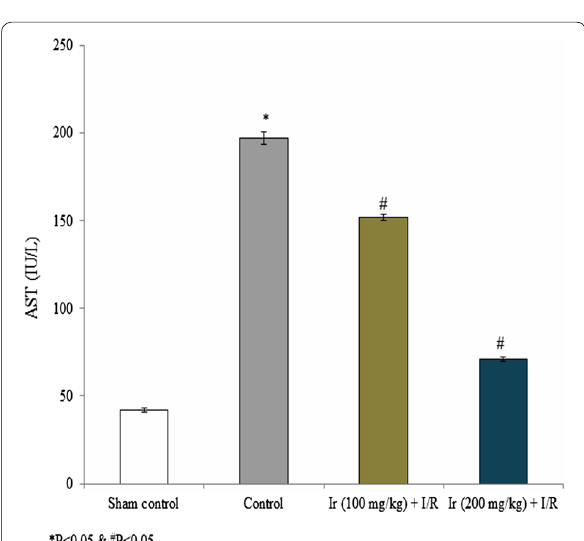
Fig. 2 Ir attenuated serum AST enzyme level. Values are expressed IU/L. Results are shown mean with SEM.